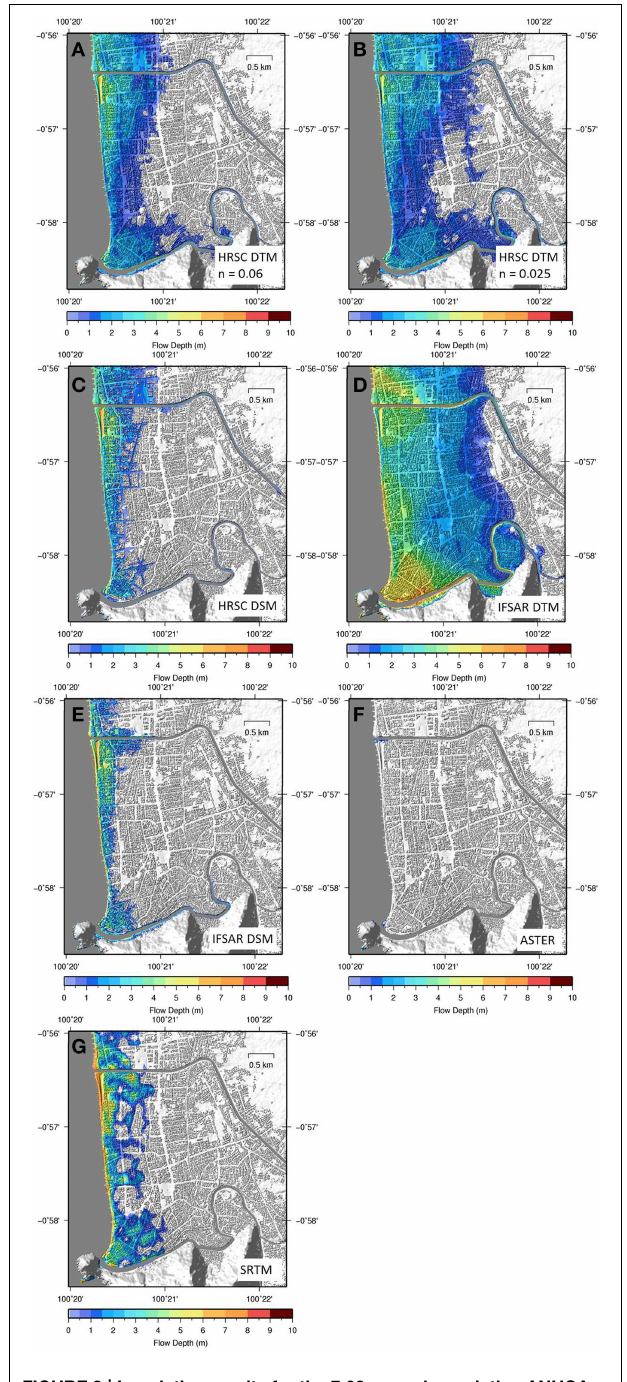
FIGURE 8 | Inundation results for the 7.62m mesh resolution ANUGA model for Padang for (A) HRSC DTM benchmark model ( n = 0 . 08 ); and